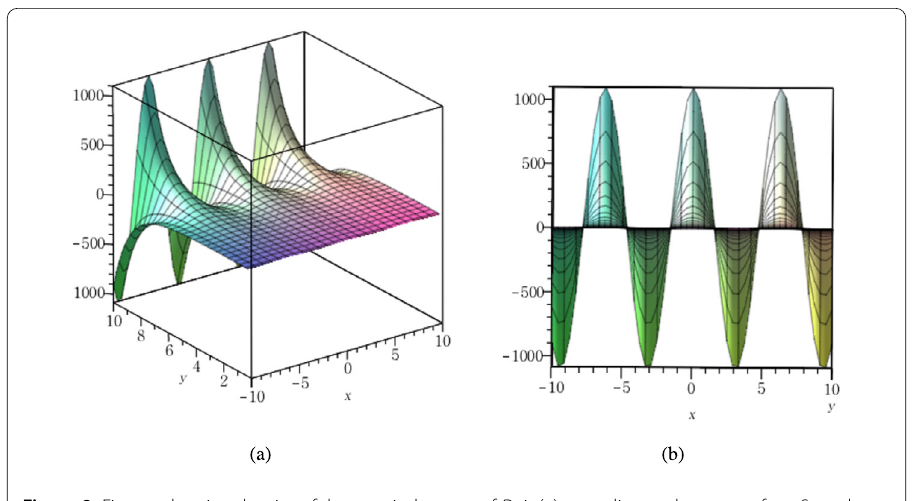
cos( x )cosh( y ) with y